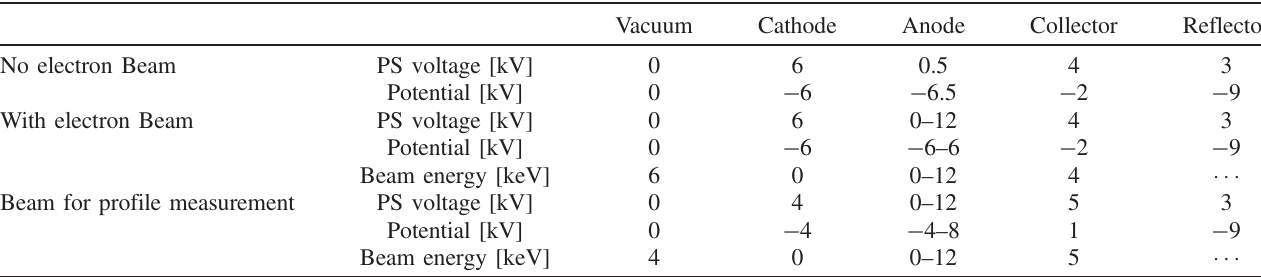
TABLE IV. Parameters for the beam potential and energy control.